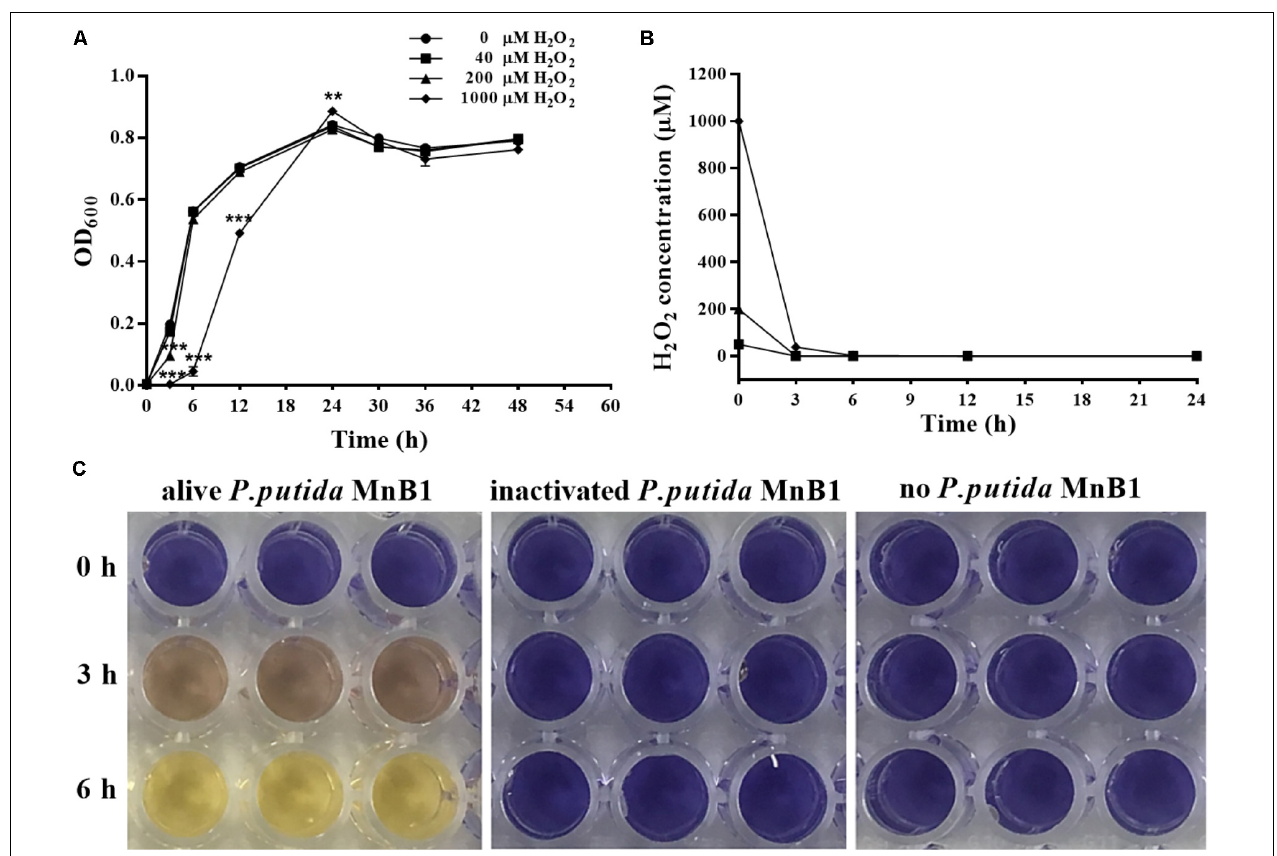
FIGURE 1 | Exogenous H 2 O 2 did not inhibit the growth of P. putida MnB1, but was bio-degraded quickly by P. putida MnB1. (A) Cells were incubated with 0, 40, 200, and 1000 µ M H 2 O 2 , respectively. Growth of P. putida MnB1 was detected by measuring the absorbance at 600 nm ( n = 3). (B) The concentration of H 2 O 2 in culture with P. putida MnB1was assayed by the xylenol orange reaction ( n = 3). (C) H 2 O 2 concentration (initial concentration of 1000 µ M) in LEP medium was assayed in the presence or absence of alive P. putida MnB1 or inactivated microbes, respectively. The supernatant of the cell culture was reacted with xylenol orange. Data were expressed as mean ± SEM. Significance, ∗∗ P < 0.01 and ∗∗∗ P < 0.001 vs. control group (0 µ M H 2 O 2 ).